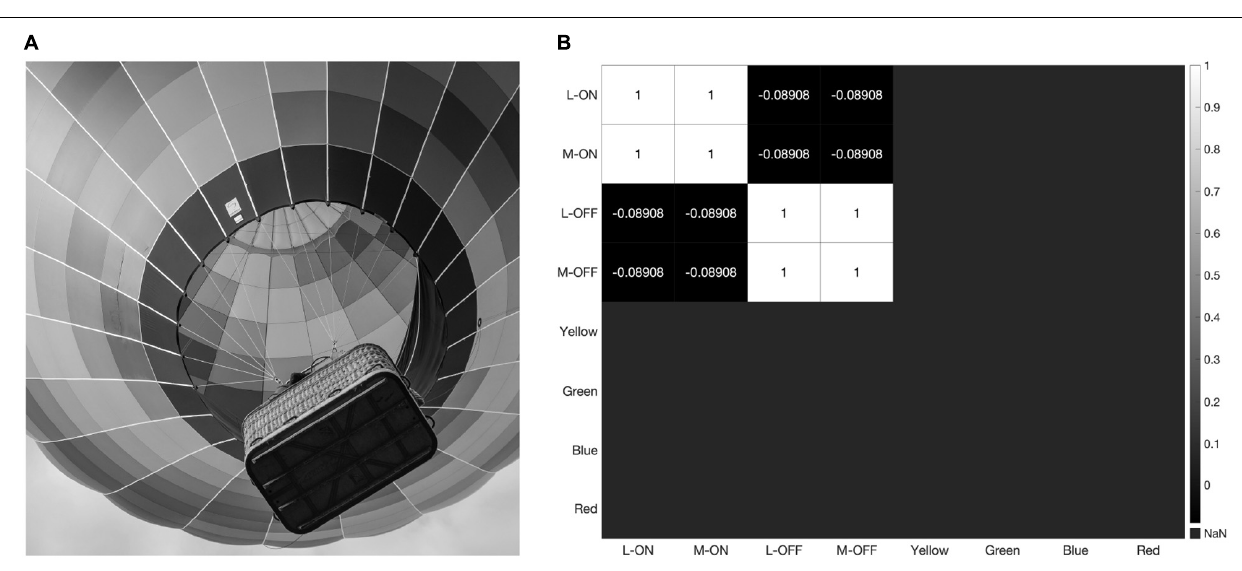
FIGURE 9 | When presented with a grayscale image (A) our model produces the correlation matrix in panel (B) where the L-ON/M-ON and the L-OFF/M-OFF receptive fields are perfectly correlated with each other, while the putative color-detecting ganglion cells in our model do not respond at